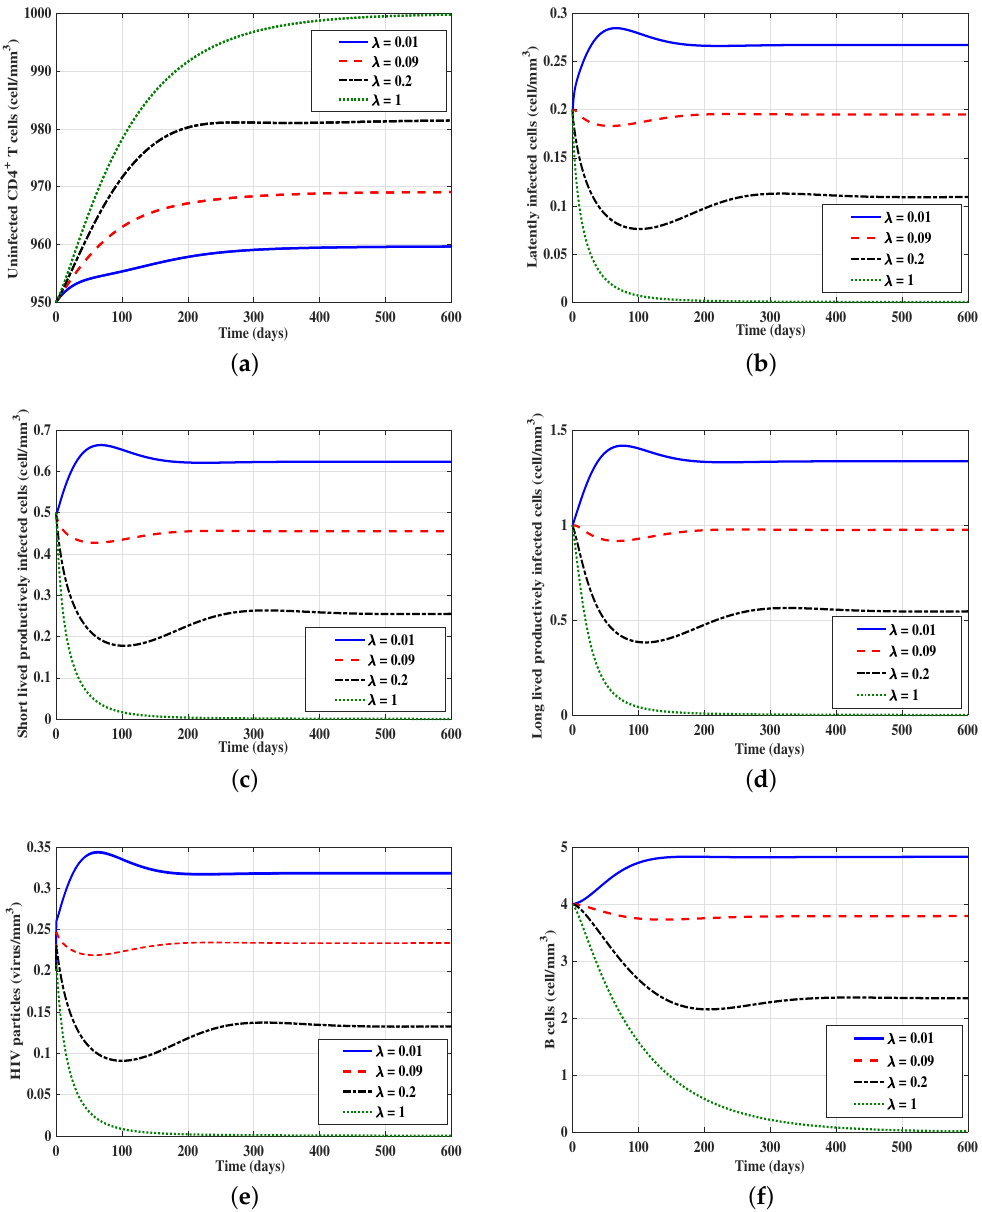
Figure 2. Effect of the time delay parameter λ on the solution trajectories of models (15)–(20) with Initial Condition 4 (IC4). In this figure, we take α 2 = 0.5, ϑ = µ = 0.01, and α 1 = 0.001. ( a ) Uninfected CD4 + T-cells; ( b ) latently-infected cells; ( c ) short-lived productively-infected cells; ( d ) long-lived productively-infected cells; ( e ) HIV particles; ( f )